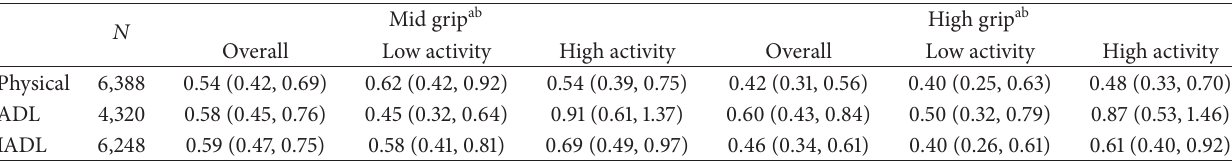
Table 3: Odds of physical and ADL limitations by grip tertile and activity level.